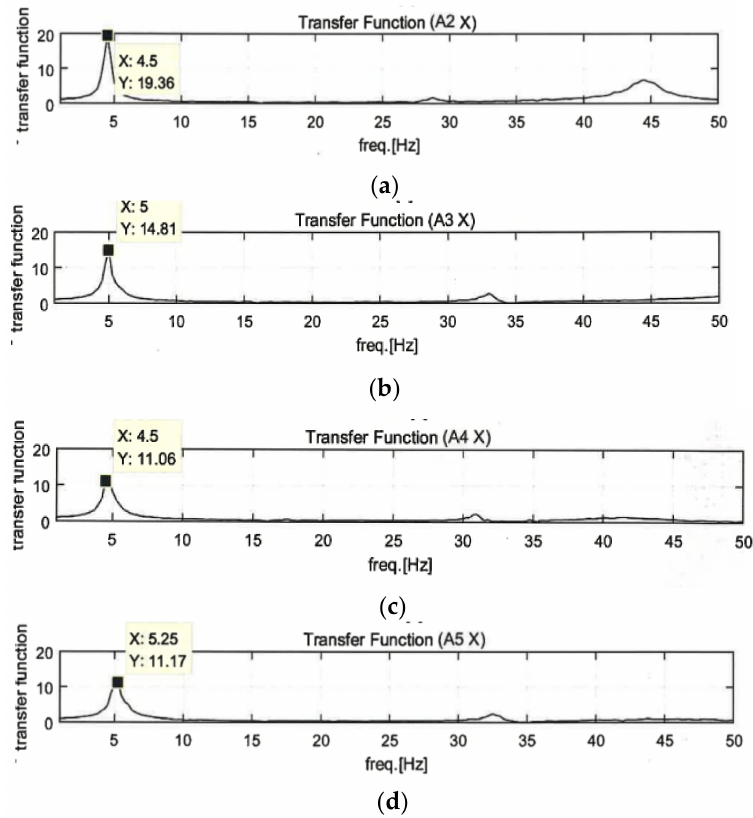
Figure 11. FFT of the displacement responses: ( a ) unreinforced specimen, ( b ) GFRPU reinforcement specimen, ( c ) LTMD control specimen, and the ( d ) hybrid control